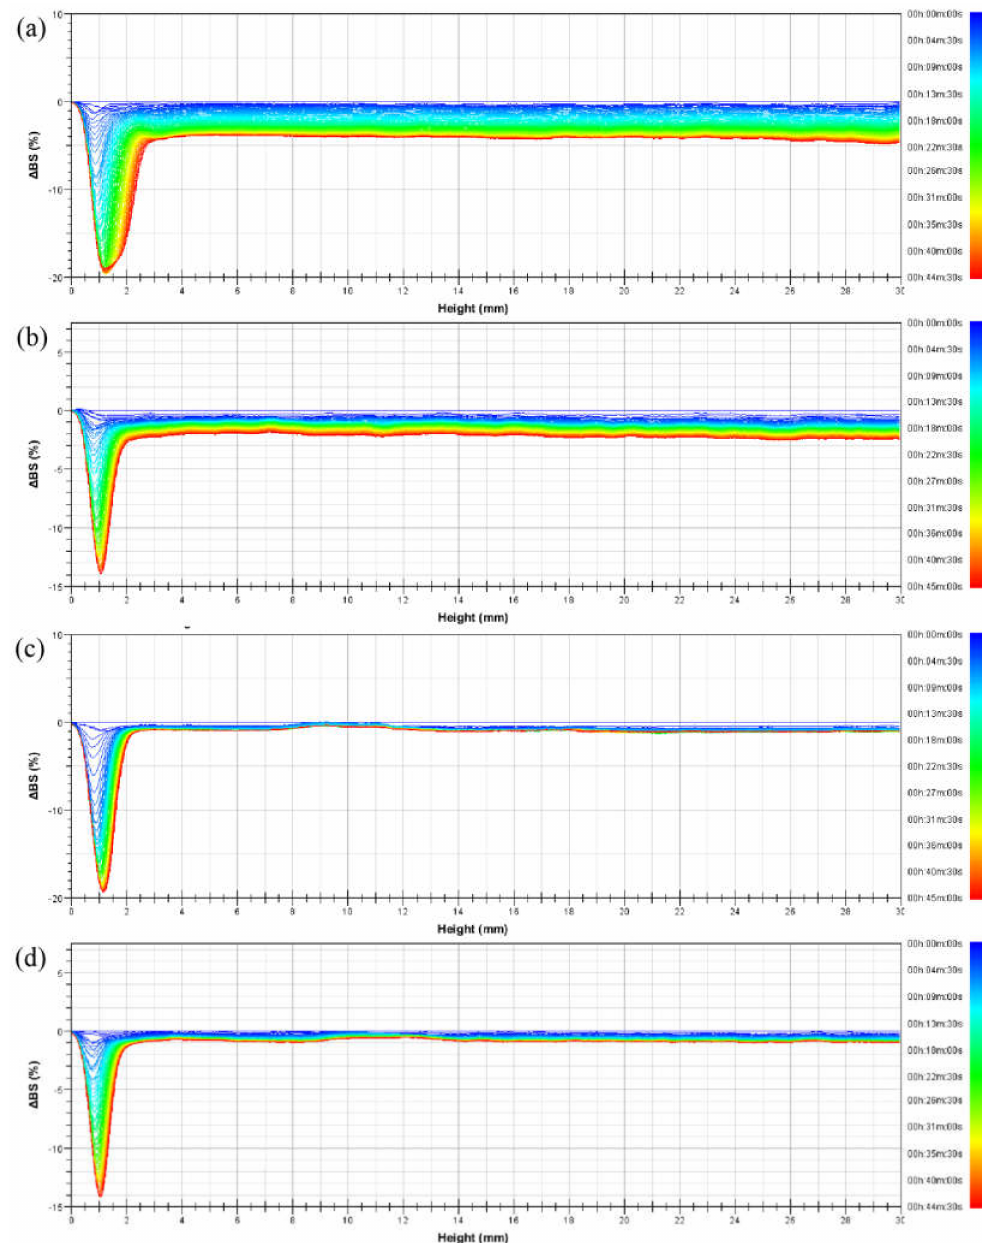
Figure 6. Delta backscattered light intensity profiles of emulsions prepared from ( a ) PASB-1, ( b ) PASB-2, ( c ) PASB-3, and ( d ) PASB-4,